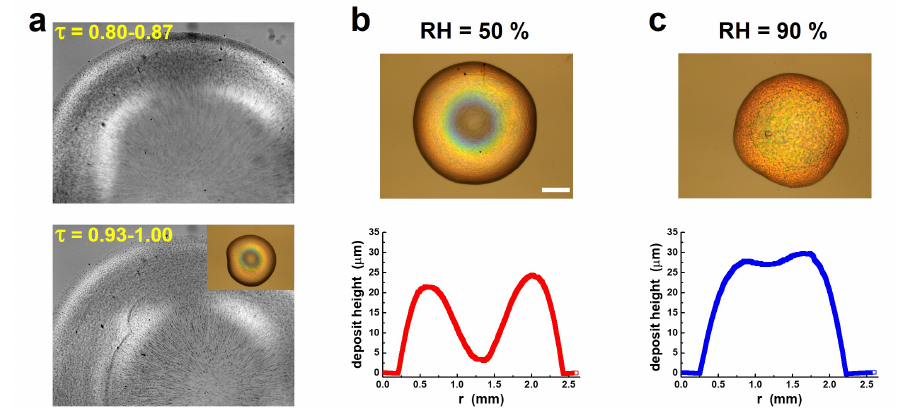
Figure 12. The coffee-ring effect in evaporating droplets of aqueous CNC suspension and its elimination via slow drying. ( a ) Superposition of transmission optical microscopy images acquired during the evaporation of a droplet (volume 1 µ L) of an unsonicated aqueous CNC suspension (starting concentration w = 4 wt.%) to which we have added 0.1 mg/mL polystyrene spheres (diameter 1 µ m). The droplet was deposited on a glass coverslip and dried at ambient laboratory conditions (relative humidity, RH = 40%). The polystyrene spheres act as tracers that enable flow visualization. The variable τ is a reduced evaporation time, τ = t / t evap , where t evap is the total evaporation time. The inset shows the colorful reflection of a fully dried film that was obtained by drying the same suspension, under very similar experimental conditions (volume 2 µ L, RH = 50%). ( b , c ) Reflection optical microscopy images and corresponding height profiles, obtained by profilometry, of CNC deposits from droplets (volume 2 µ L) of unsonicated aqueous CNC suspensions (starting concentration w = 5 wt.%) deposited on glass coverslips, dried at low ( RH = 50%, a) and high ( RH = 90%, b) relative humidity; from M.Sc. thesis of M. Dupas, U. Luxembourg 2018, supervised by M.